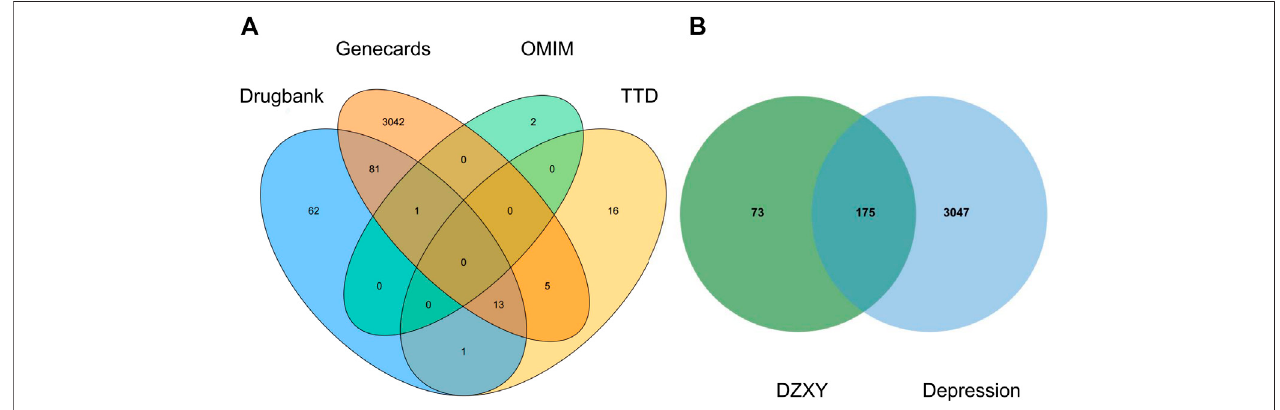
FIGURE 5 | Venn diagrams showing depression targets obtained from four databases (A) and the intersection of identi fi ed target genes of active compounds and depression (B) , respectively.